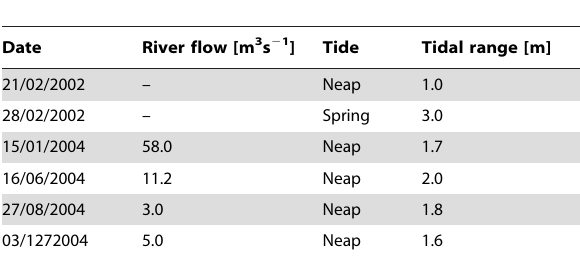
Table 1. Summary of tidal and river discharge conditions during the survey